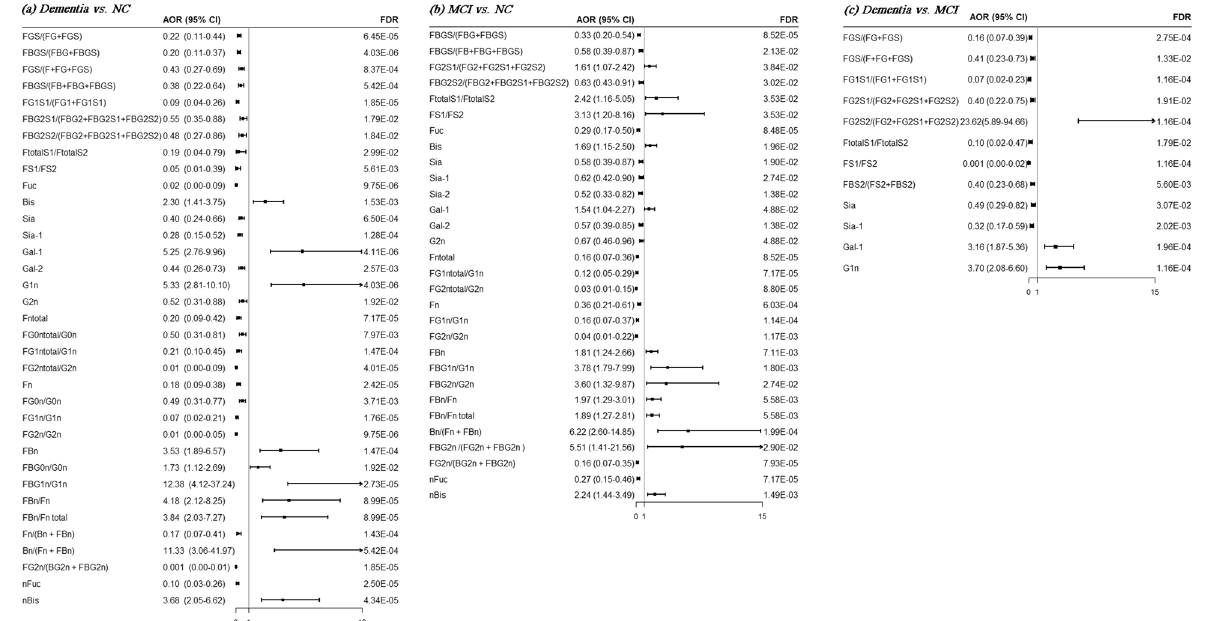
Fig. 2 Forest plots of the associations of the derived traits with MCI and dementia. Forest plots ( a – c ) show the odds ratios (ORs, black solid square) with a horizontal lines representing 95% con fi dence intervals (CIs) for derived traits with MCI and dementia. Each of statistically signi fi cant derived traits included study is represented by one row in the plots. The multiple logistic regression analysis was performed after adjusting for age, sex, BMI, levels of education, history of malignant tumor, habit of salt intake, ischemic stroke, diabetes, hypertension, and dyslipidemia (adjusting for the above effects other than age and sex for dementia vs. NC). a Dementia vs. NC, b MCI vs. NC, and c Dementia vs. MCI. NC normal cognitive functioning, AD Alzheimer ’ s disease.